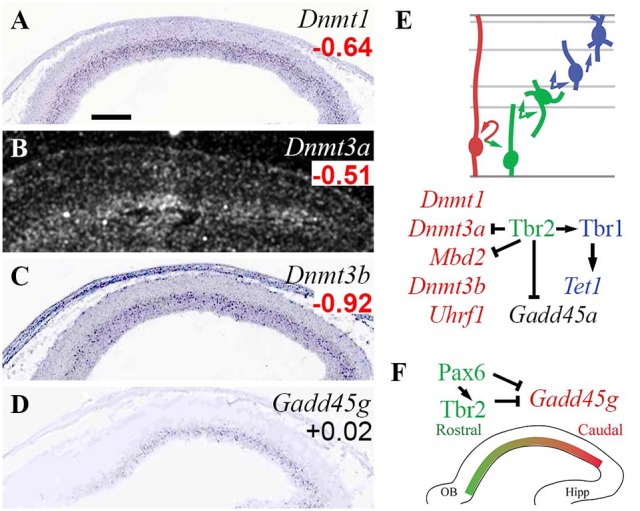
Expression and regulation of DNA methylation/demethylation factors. (A–D) Expression of the indicated genes in E14.5 mouse neocortex. Dnmt1
(A), Dnmt3a
(B), and Dnmt3b
(C) were expressed in VZ, and were significantly enriched in Tbr2-GFP− cells, defining them as RGP markers (Supplementary Table S2). Gadd45g
(D), part of a pathway for DNA demethylation, was expressed in a high caudal gradient in the VZ, but was not significantly enriched in RGPs or IPs on microarray. (Significant log2FC values are indicated by bold text, in red or green). Sagittal sections, rostral left, ventral down (see also Supplementary Figure S1). ISH: Genepaint (A,C,D) and BGEM (B; darkfield). Scale bar: 100 μm. (E) Cell-type-specific gene expression and regulation by TFs. Arrows, direct transcriptional activation; bars, direct repression. (F) Pax6 and Tbr2 may shape the Gadd45g gradient by direct repression.